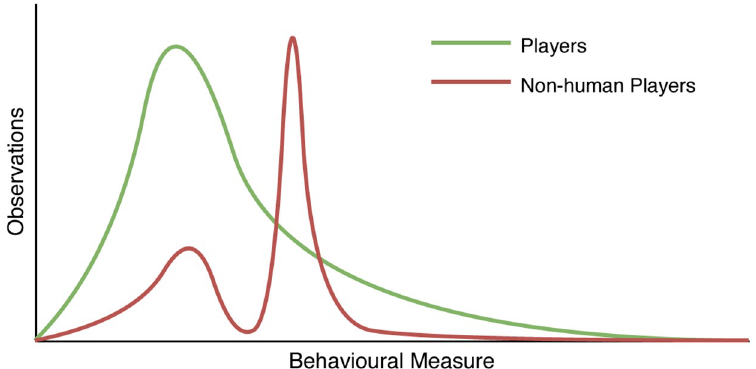
Fig 4. Theoretical differences in distributions of behavioural measures between human and non-human players. The second spike is created when multiple addresses transact in the same way, e.g. using by using computer code.